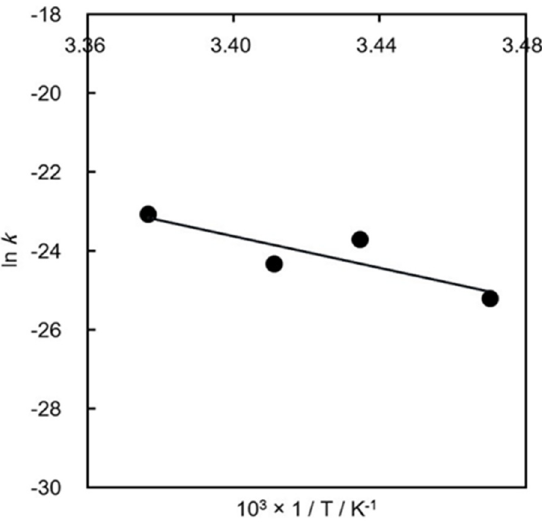
Figure 2. Arrhenius plots of experimental and calculated rate constants for the reduction of nitrite to ammonium with NiR derived from spinach.